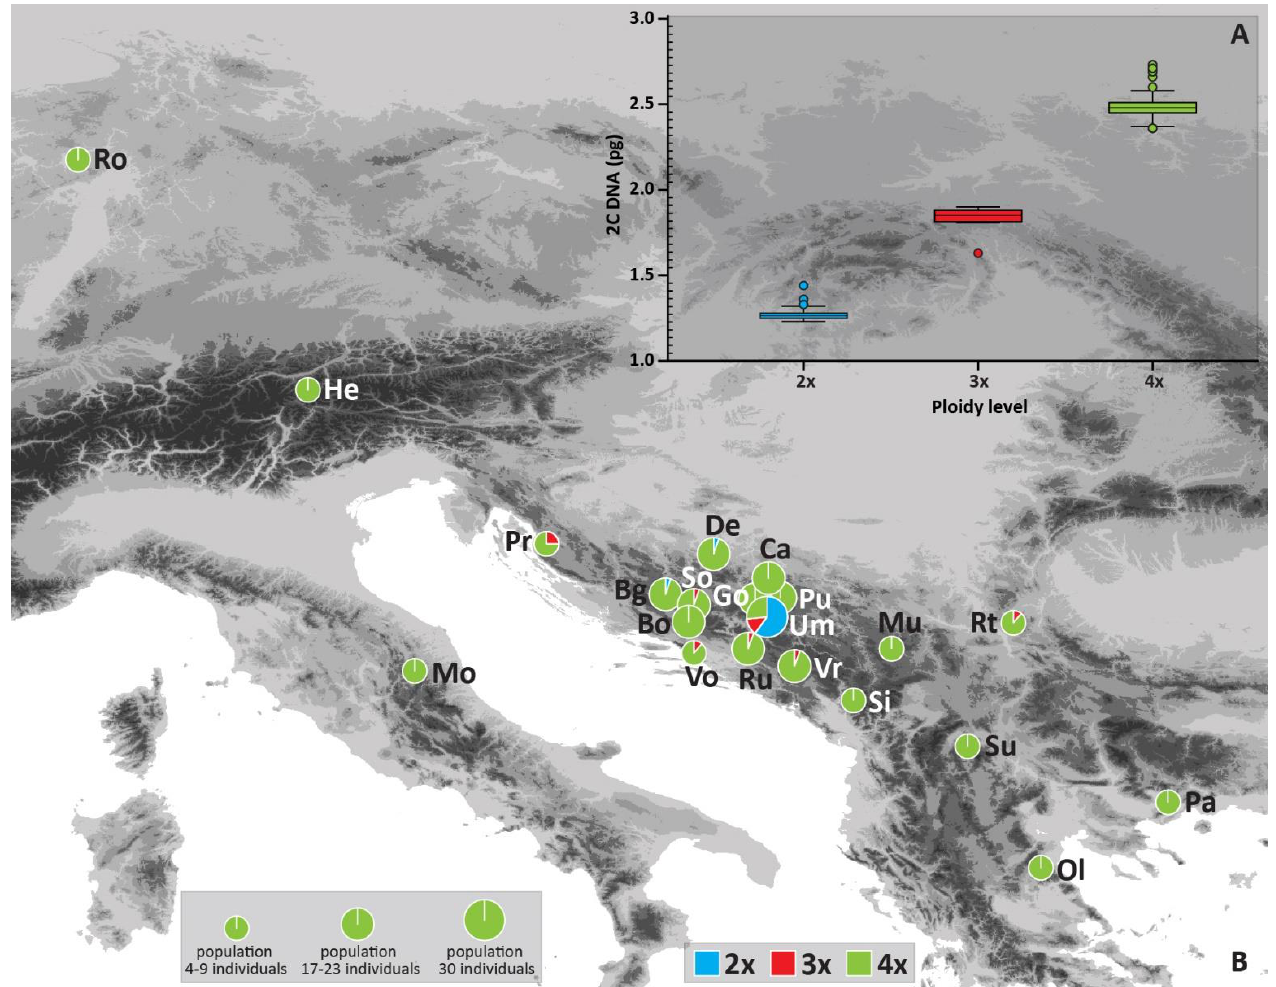
Figure 1. Absolute nuclear genome size (2C) of diploid, triploid, and tetraploid cytotypes ( A ) (boxes define 95th percentile interval; horizontal lines indicate mean value; whiskers indicate standard deviation: outliers are shown as circles), and geographical distribution of Cotoneaster integerrimus cytotypes and their frequency (%) per site/population ( B ). Site abbreviations (Site IDs) correspond to Table 2. Table 2. Geographic origin of Cotoneaster mother individuals covering three cytotypes and corresponding sample sizes ( N ) for genome size/ploidy level, reproductive mode, and microsatellite analysis.